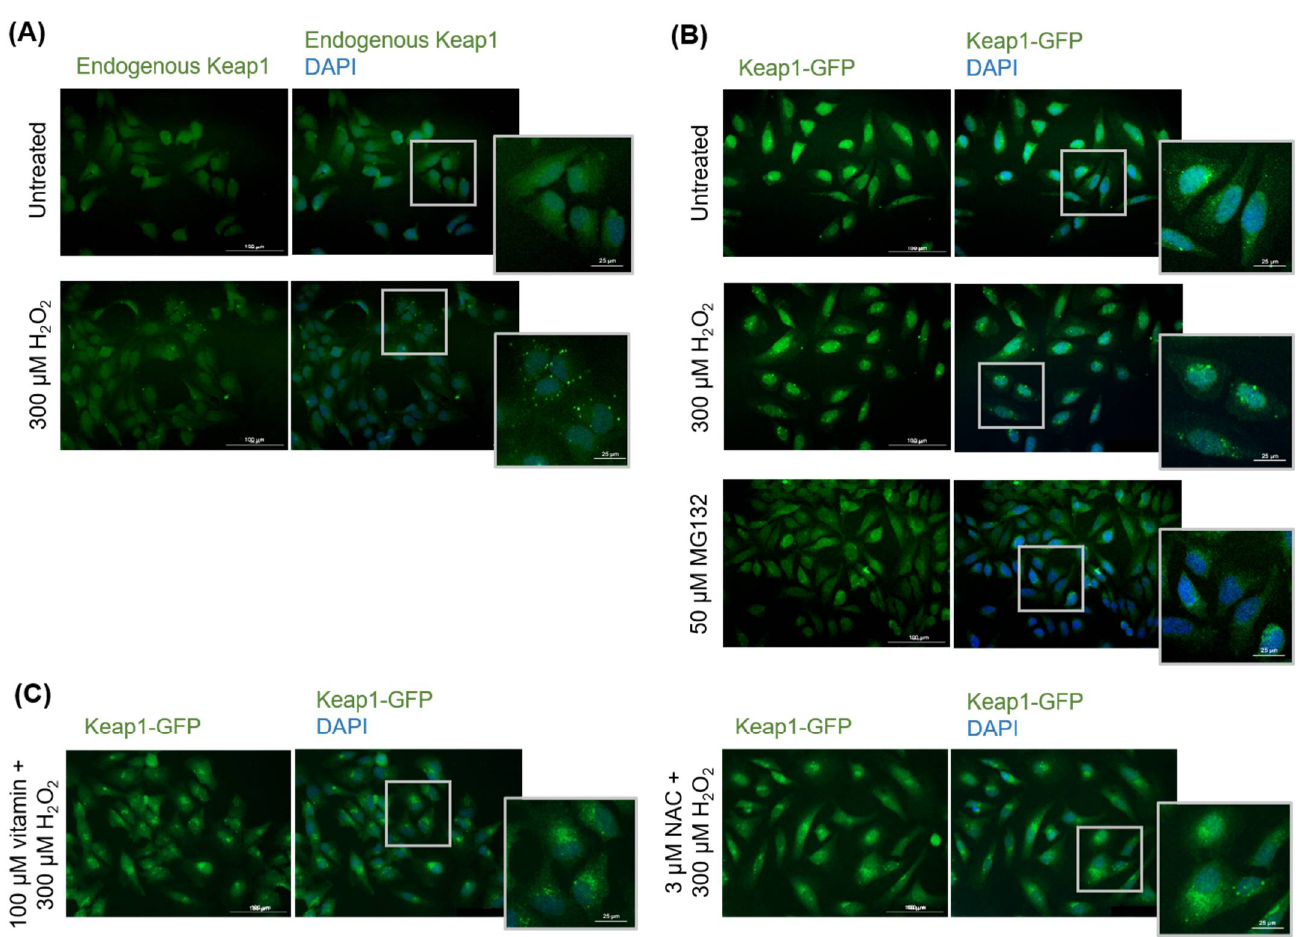
Figure 6. Further analyses of Keap1 oxidative stress-induced protein misfolding. ( A ) Endogenous Keap1 in un-transfected HeLa cells treated with 300 µM H 2 O 2 for 3 h, visualized by immunofluo- rescence microscopy. ( B ) Transfected Keap1-GFP in HeLa cells treated with 50 µM MG132 for 6 h, visualized by fluorescence microscopy. ( C ) Transfected Keap1-GFP in HeLa cells pretreated with 100 µM vitamin C or 3 µM NAC for 24 h followed by treatment with 300 µM H 2 O 2 for 3 h, visualized by fluorescence microscopy.